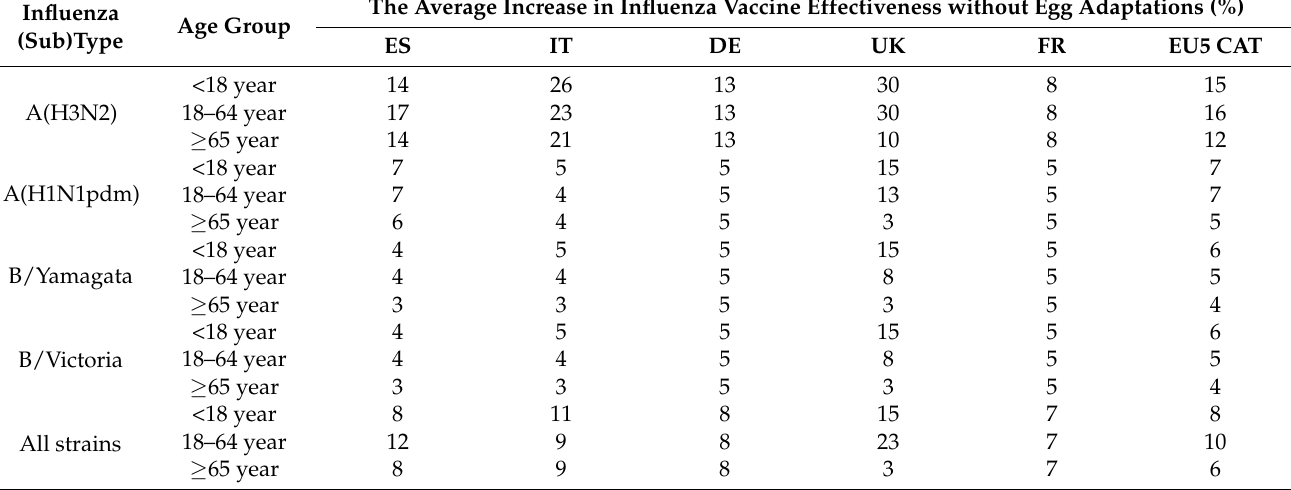
Table A1. Country-level and EU5-level survey responses on the IVE increase without egg adaptations.